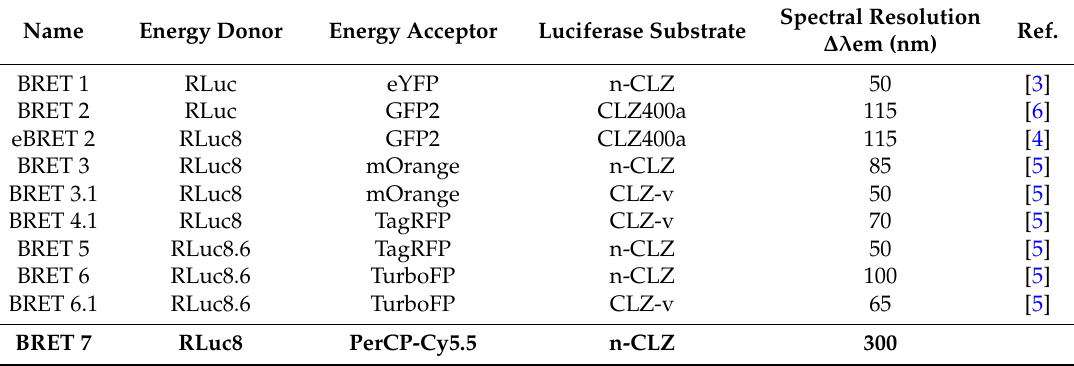
Table 1. Different BRET pairs used in protein research. Bioluminescence resonance energy transfer (BRET), Renilla reniformis luciferase (RLuc), enhanced yellow fluorescent protein (eYFP), green fluorescent protein (GFP), red fluorescent protein (RFP), fluorescent protein (FP), coelenterazine